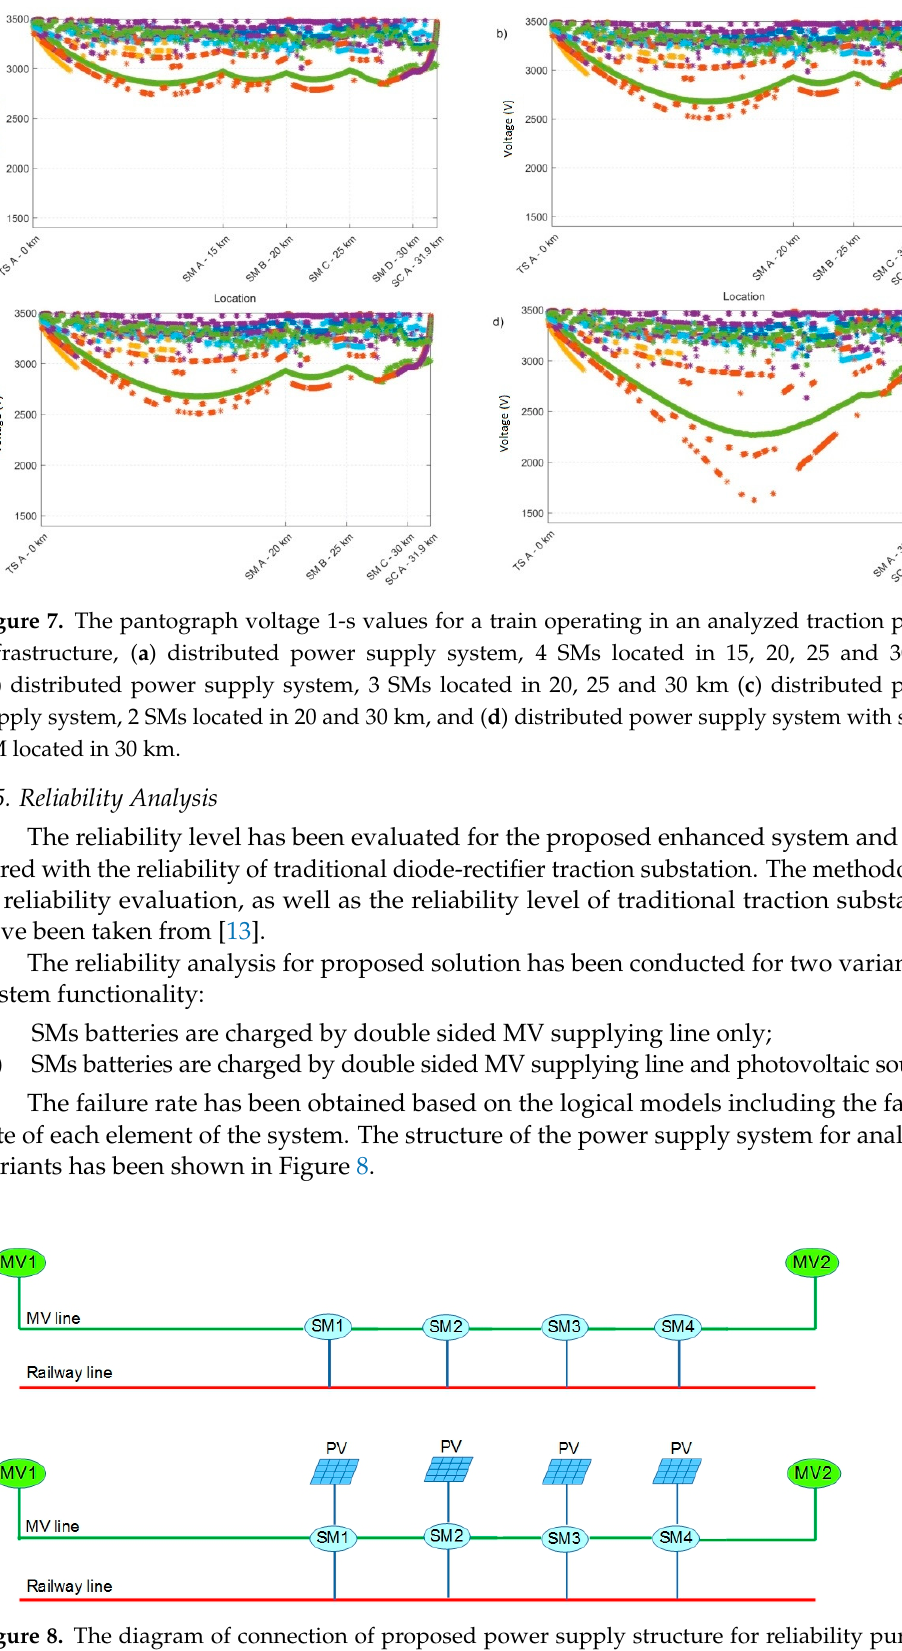
Figure 8. The diagram of connection of proposed power supply structure for reliability purpose, ( a ) ( a ) supplying modules (SM) connected to MV line, and ( b ) supplying modules connected to MV line supplying modules (SM) connected to MV line, and( b ) supplying modules connected to MV line and photovoltaic sources. and photovoltaic